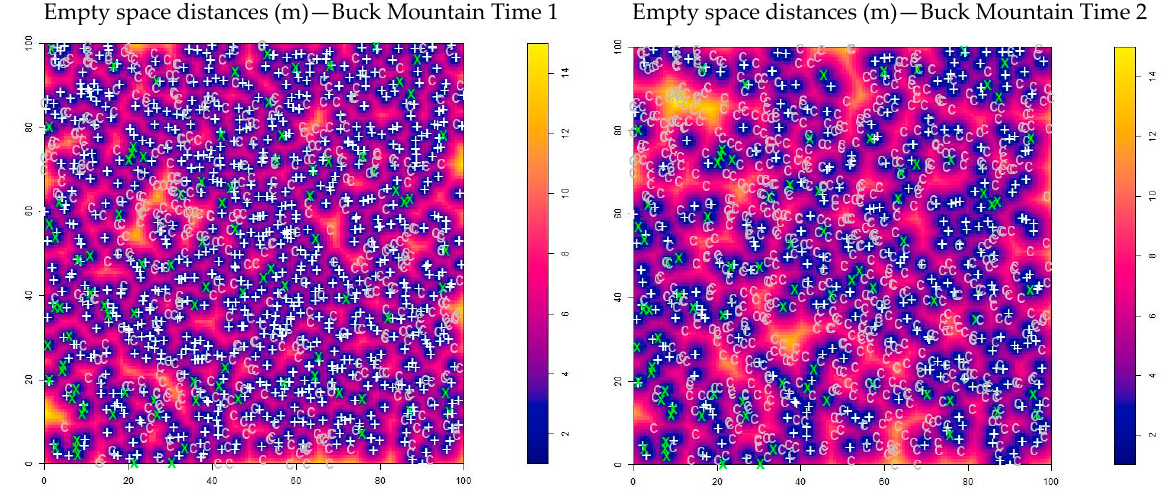
Figure 12. “Empty space distance” maps for all live trees, all species, for the Buck Mountain plot. Time 1 ( left ) is the plot establishment (1999) and Time 2 ( right ) is the 2013 assessment. The side ribbons are in meters. Subalpine fir = +; spruce = X; dead trees = C (tree codes 1–7). Dead trees (C) are an overlay on the map and do not factor into the actual distance calculations.